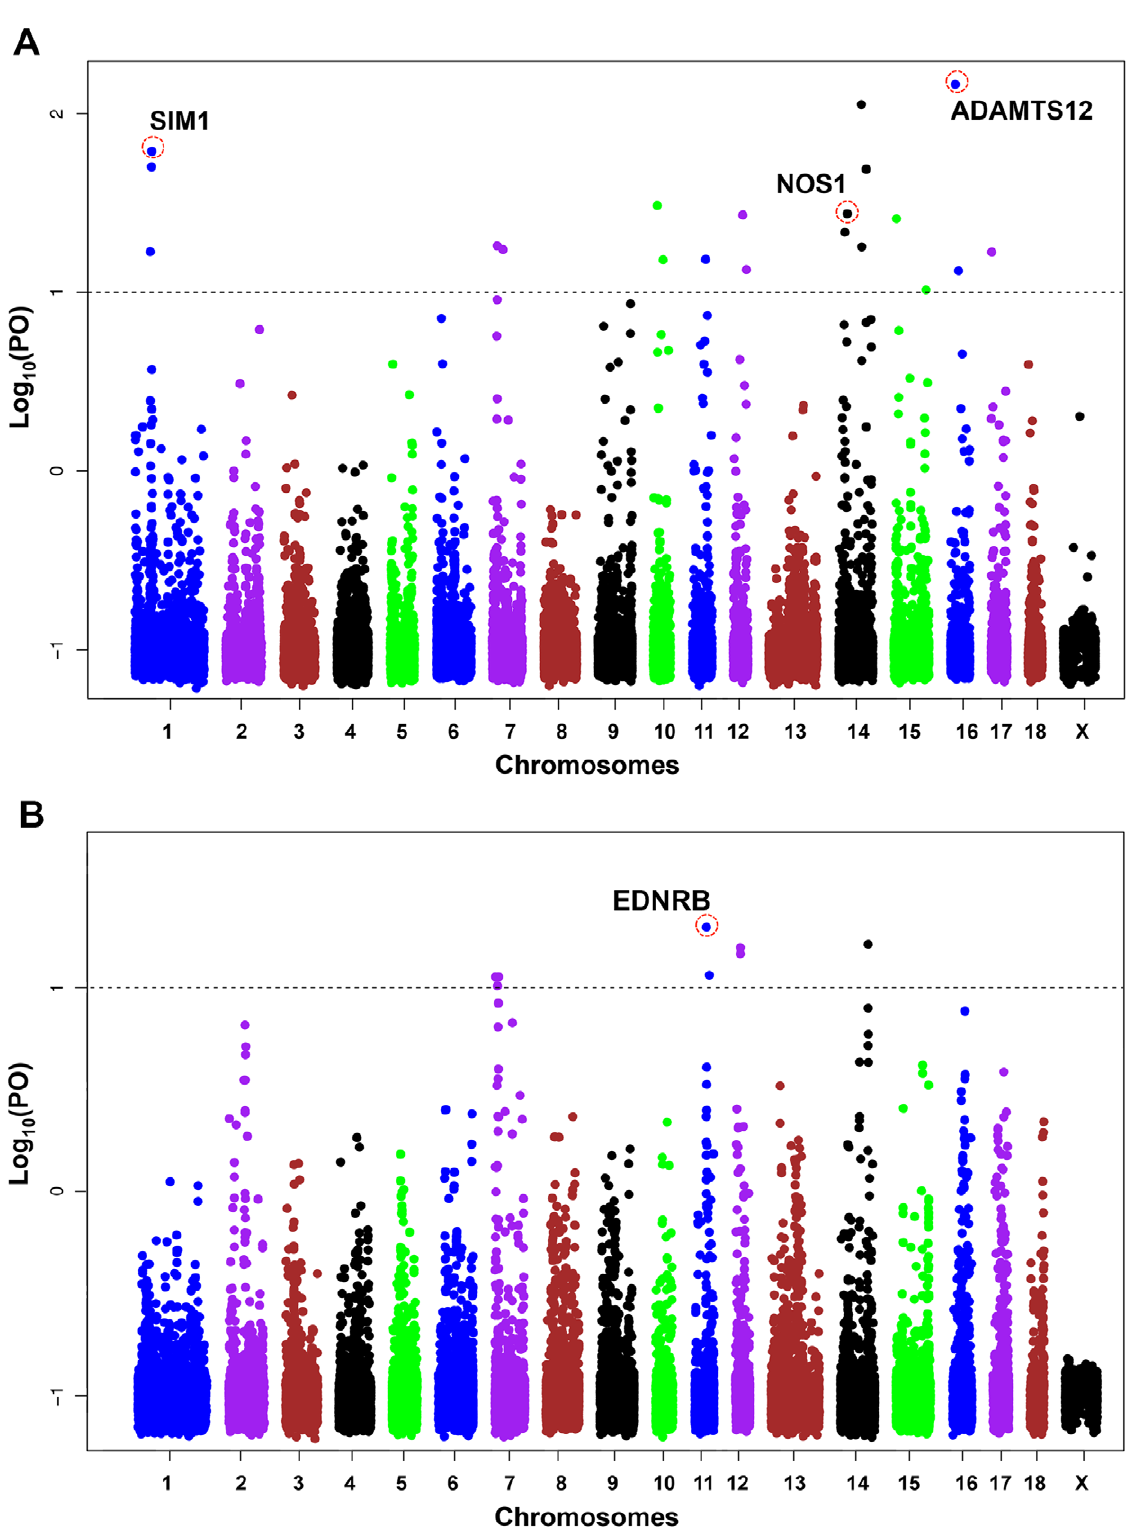
Figure 6. Genome-wide distribution of log 10 Bayes factor values in two contrasts. (A) Tibetan pigs versus non-plateau pigs. (B) Belted pigs against non-belted pigs. The chromosomes are plotted along the x-axis, and log 10 Bayes factor values are plotted along the y-axis. Chromosomes are indicated by different colors, and the threshold indicating signature of selection is denoted with a dashed grey line. In the upper panel, three highlighted genes that are likely involved with Tibetan high-altitude adaptation are circled in red, and the gene names are labeled above. For the contrast analysis between belted pigs and non-belted pigs, the top signal was detected at the EDNRB locus that is indicated in the lower panel.